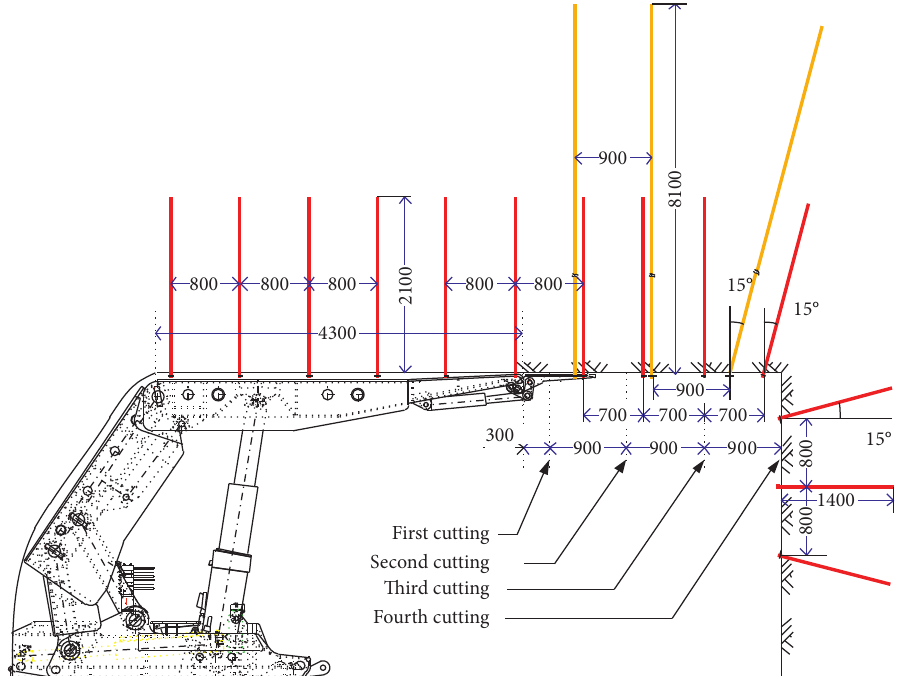
Figure 17: Support scheme for removal